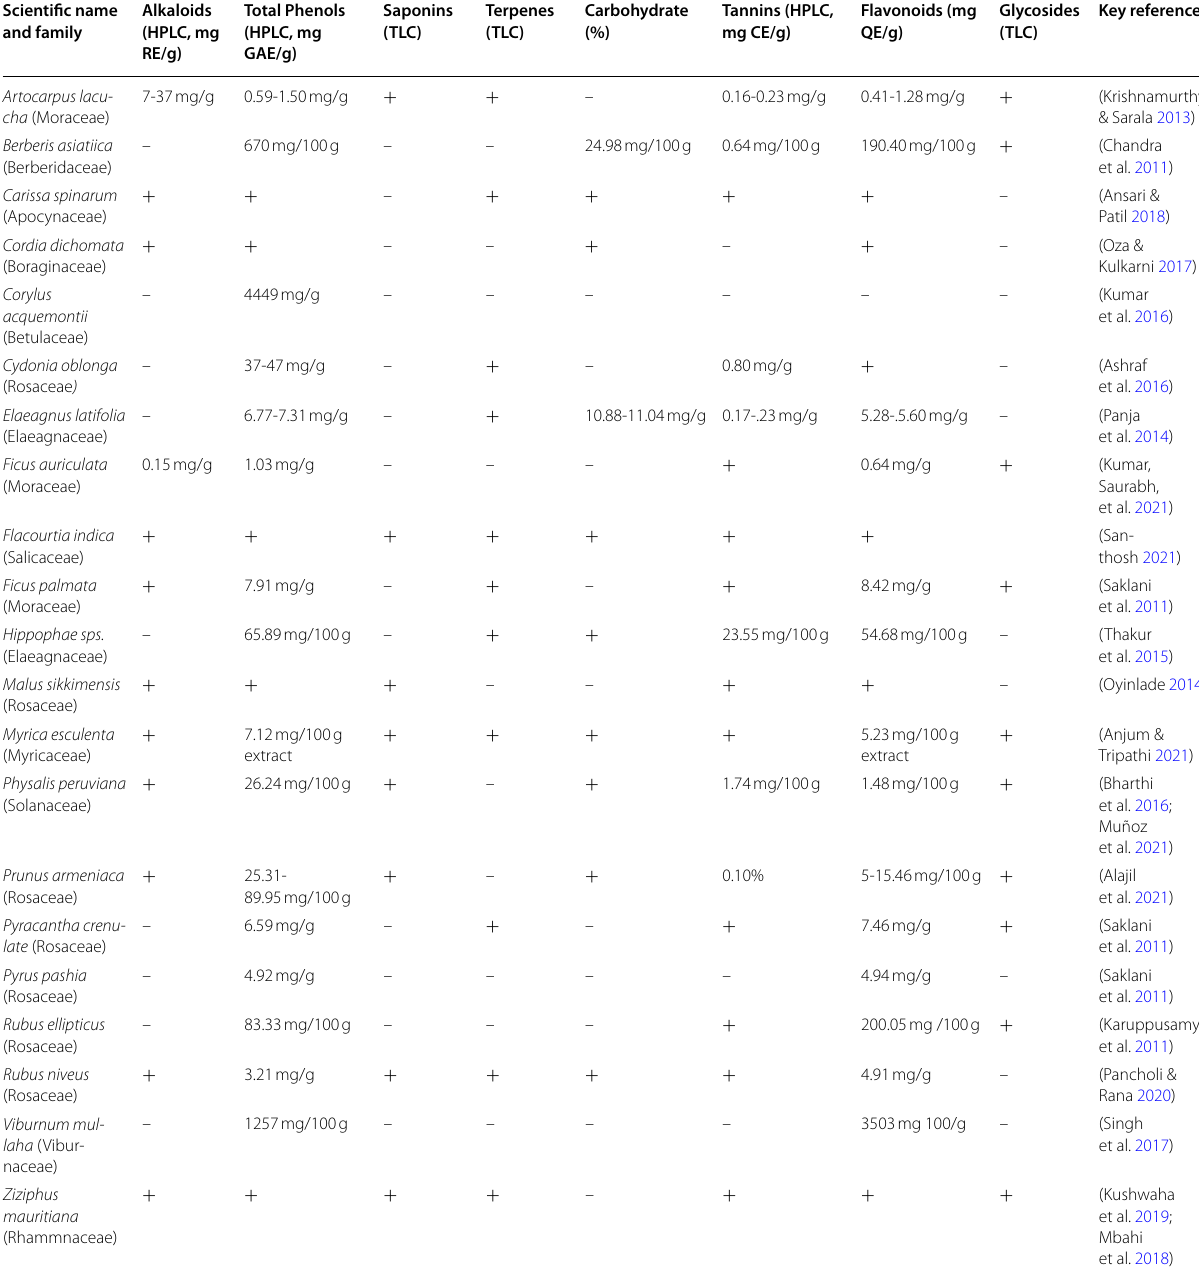
Table 4 Phytochemical profile of underutilized fruits of the Northern Himalayas